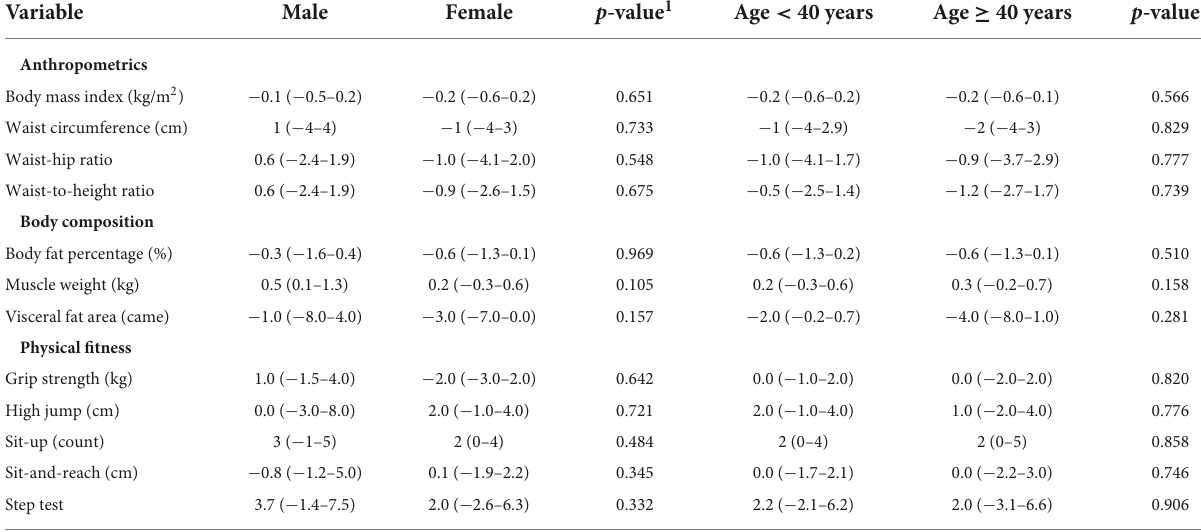
TABLE 3 Changes in outcome parameters stratified by sex and